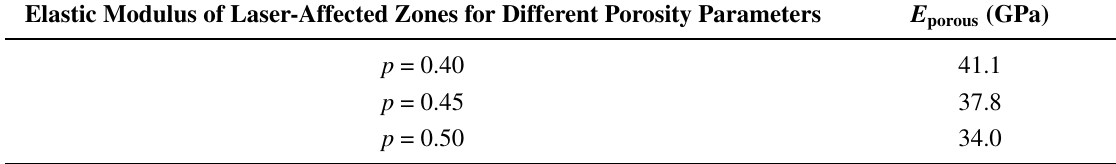
Figure 7. Analytical model for different values of elastic modulus for the laser-affected zones and experimental data of the induced volume variation in the device. The experimental data were corrected with the measured factor of out-of-plane motion displacement of the device. Table 1. Estimation of the laser-affected zones elastic modulus of the using the Phani-Nuyogi empirical relationship [63]. Elastic Modulus of Laser-Affected Zones for Different Porosity Parameters